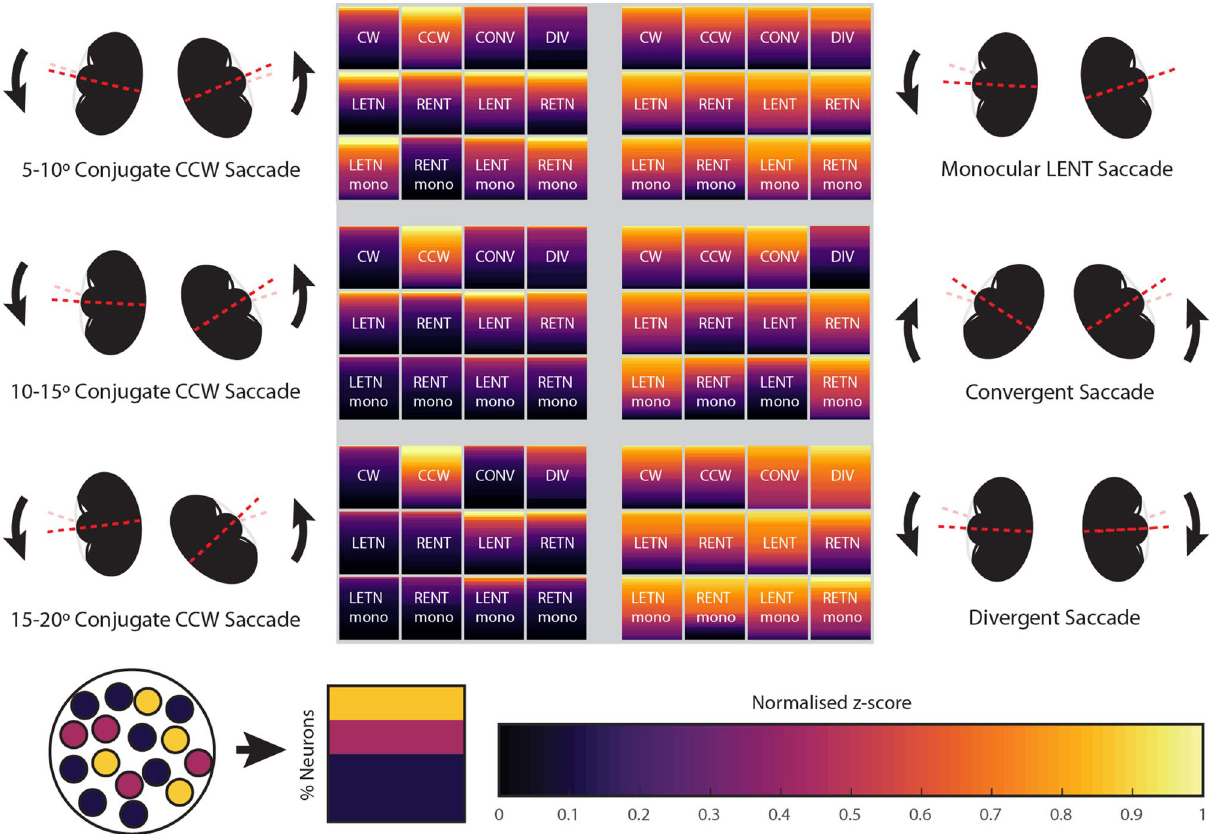
Figure 7. Summary of observed hindbrain saccade-associated activity across different saccade types. Each square refers to the population of neurons listed, except in the case of CW and CCW which refer to CW-LETN- RENT and CCW-LENT-RETN type neurons (see Fig. 4b). For each neuron population and saccade type, the percentage of active neurons and their levels of activity are illustrated by the covered area within the square and the color distribution, respectively (see color legend). The activity of the 12 neuron types is plotted for six different saccade types. Note that many populations are active during small saccades (5°–10° conjugate CCW), even neurons with opposing directional selectivity (e.g. LETN and LENT). However, for large saccades (15°–20° conjugate CCW) mainly the CCW-LENT-RETN population is active, which supports a push–pull encoding of saccade size. CW clockwise; CCW counter-clockwise; CONV convergent; DIV divergent; LE left eye; RE right eye; NT nasal-temporal; TN temporal-nasal; mono monocular eye